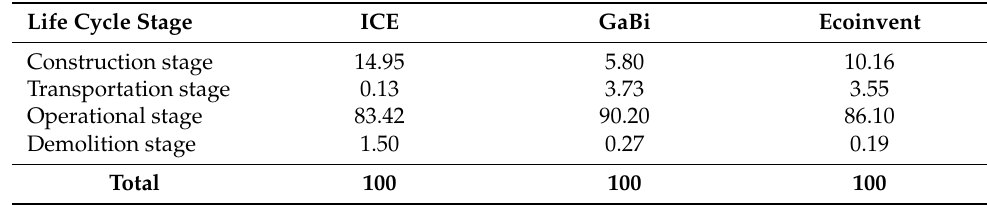
Table 9. Percentage contribution of carbon emissions in different